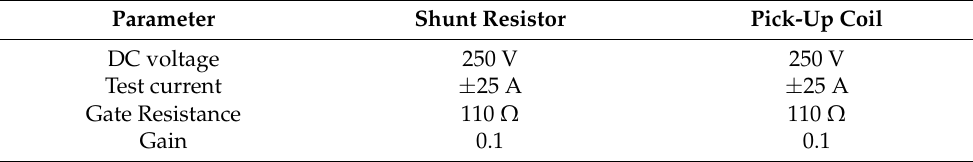
Table 7. The double pulse test circuit (DPT) test conditions for each current sensor.